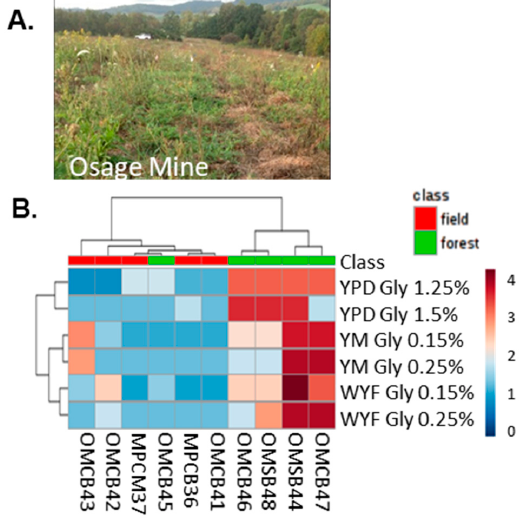
Figure 6. Phenotypic variation in S. cerevisiae from Osage Mine to glyphosate. ( A ) Osage mine during the summer after spraying with glyphosate (Credit41). ( B ) Heatmap of hierarchical clustering of S. cerevisiae grown in glyphosate. Yeast were serial diluted and grown on rich media (YPD), minimal media (YM), and minimal media supplemented with aromatic amino acids (WYF) with the noted amount of glyphosate w/v from the commercial formulation (Credit41).